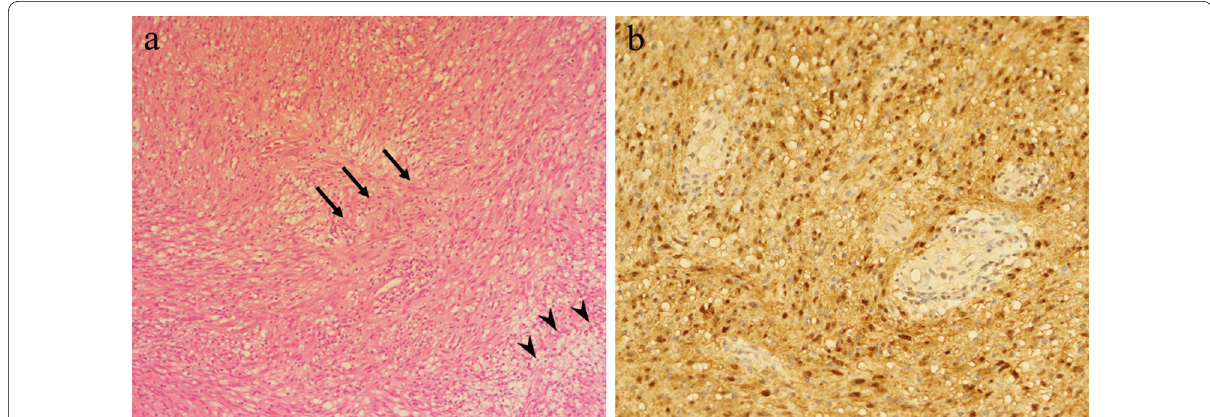
Fig. 6 Histopathological findings. a The tumor was mainly composed of spindle cells and hypercellular (Antoni type A) (black arrow) and hypocellular (Antoni type B) (black arrowhead) areas (hematoxylin–eosin stain, original magnification revealed that the tumor was strongly positive for S-100